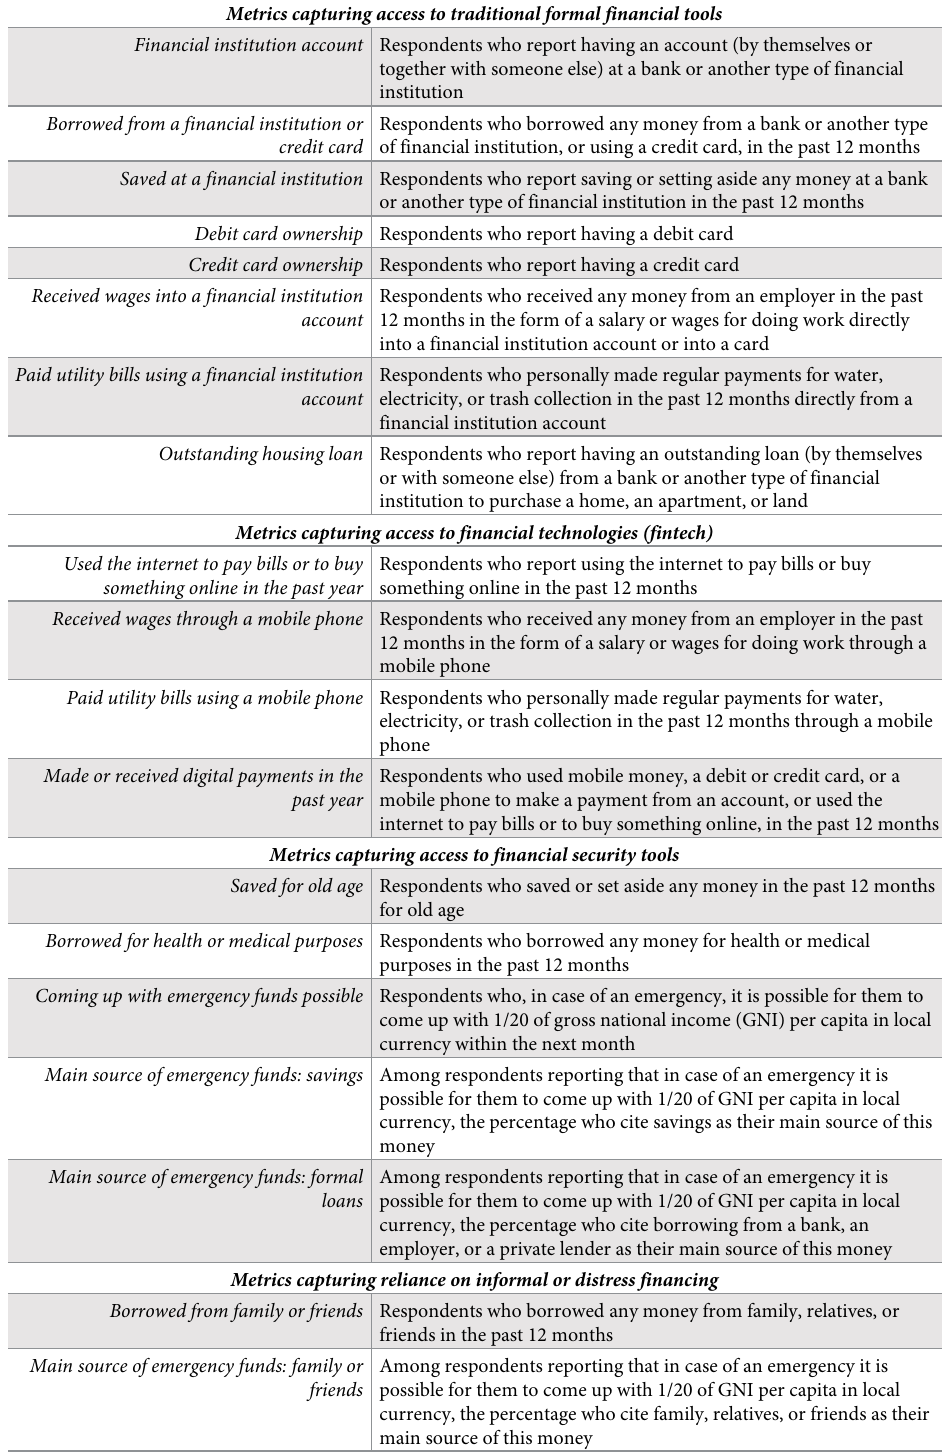
Table 2. Global Findex variables used to construct financial access indices (% age